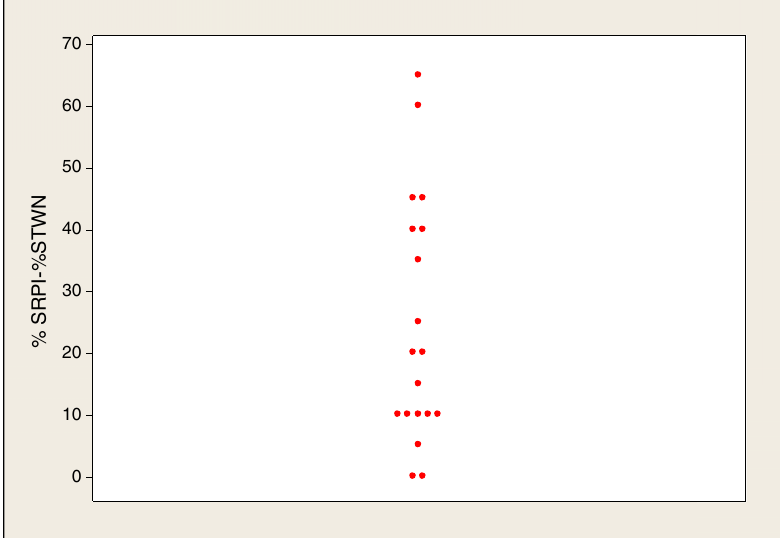
Figure 1 Individual values of the difference between the percentages of correct answers in the SRPI with pictures and STWN with pictures (SRPI, Speech Recognition Percentage Index; STWN, Speech Test with White